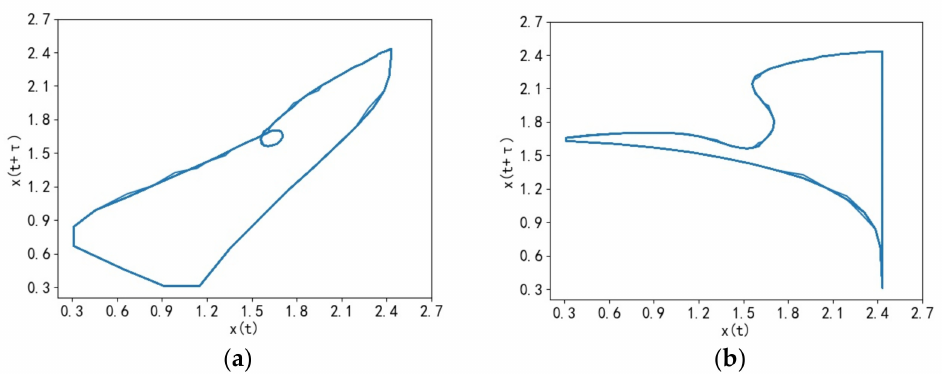
Figure 4. Phase trajectory with delay time τ = 3, 15: ( a ) τ = 3; ( b ) τ =